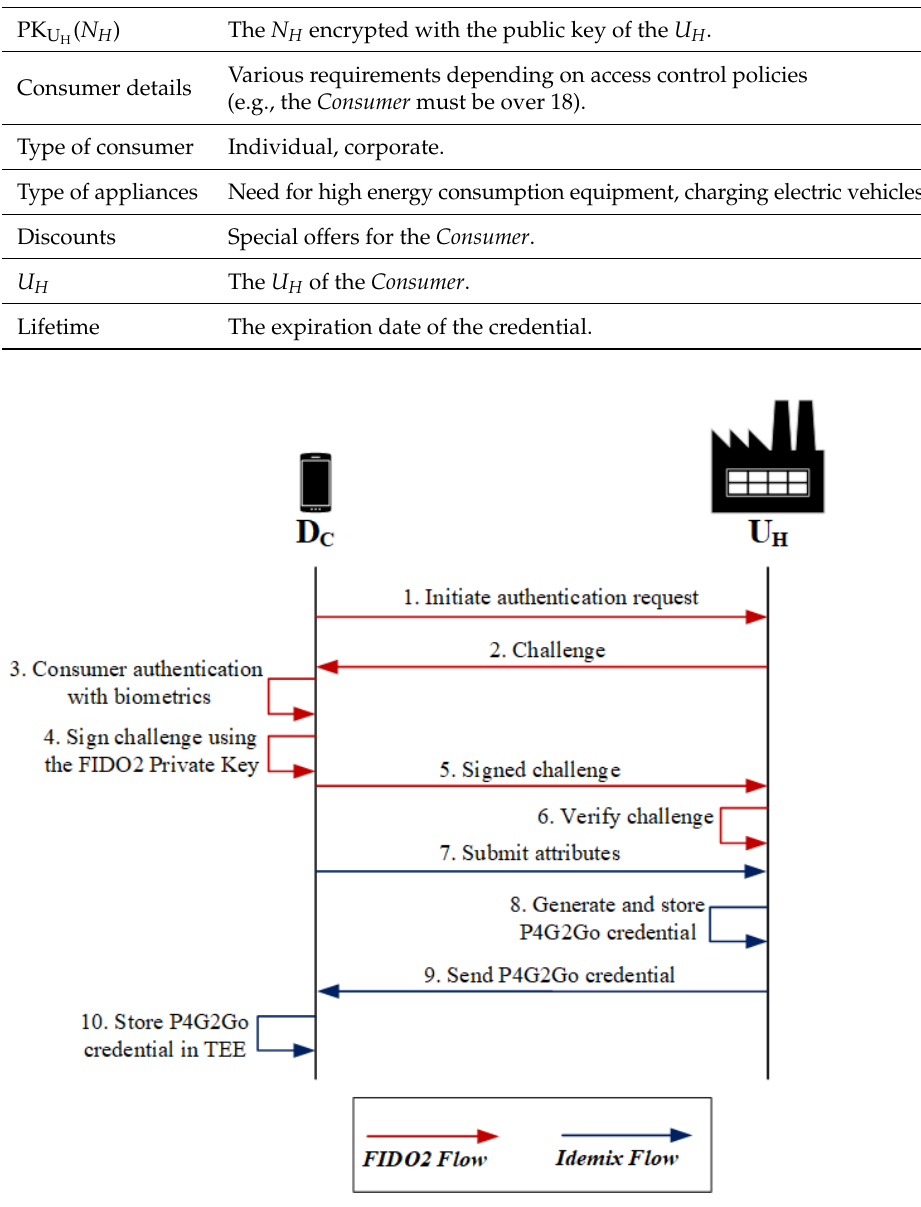
Figure 3. P4G2Go credential issuance.